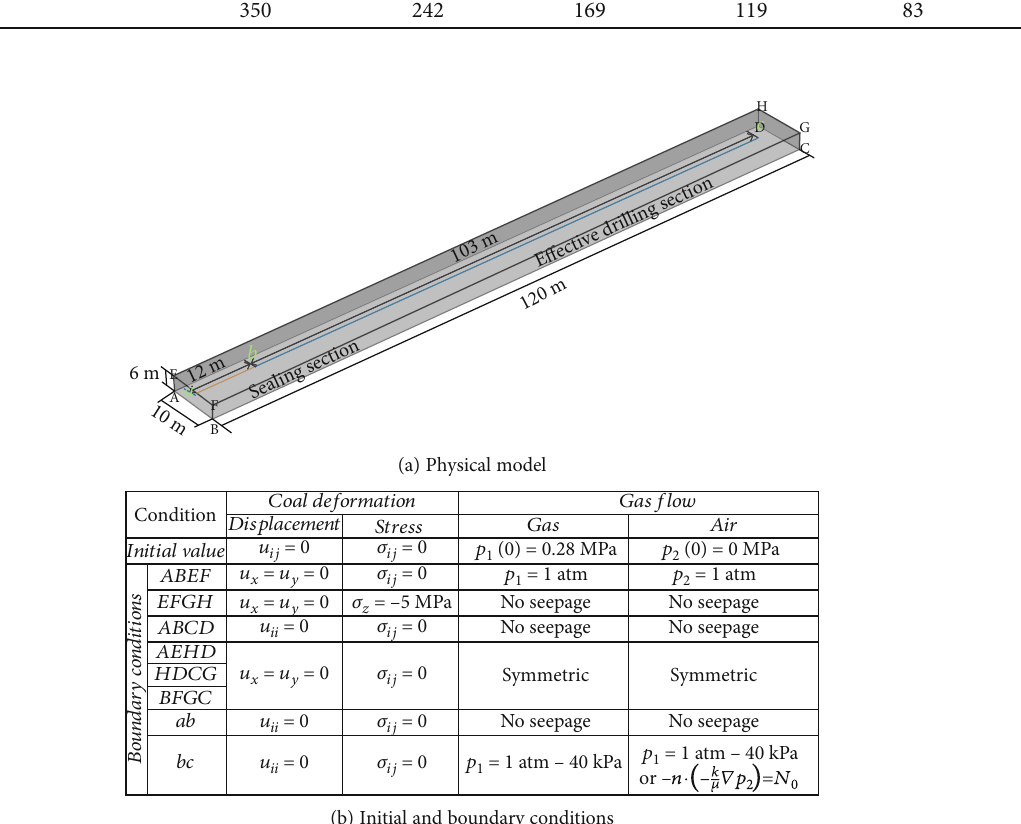
Figure 6: Physical model of gas extraction borehole and its initial boundary conditions.